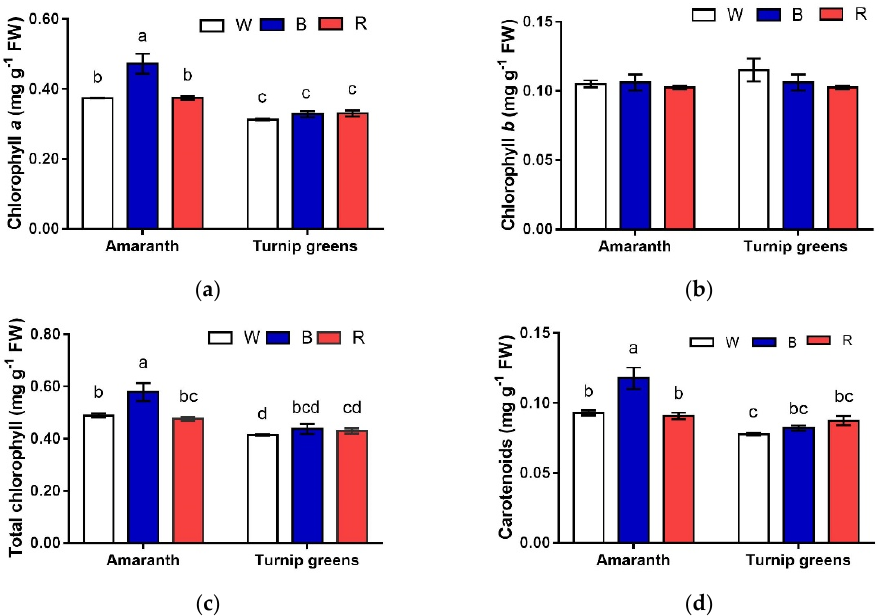
Figure 3. Interaction effect of species × light treatment (W = white, B = blue, R = red) on chlorophyll ( a